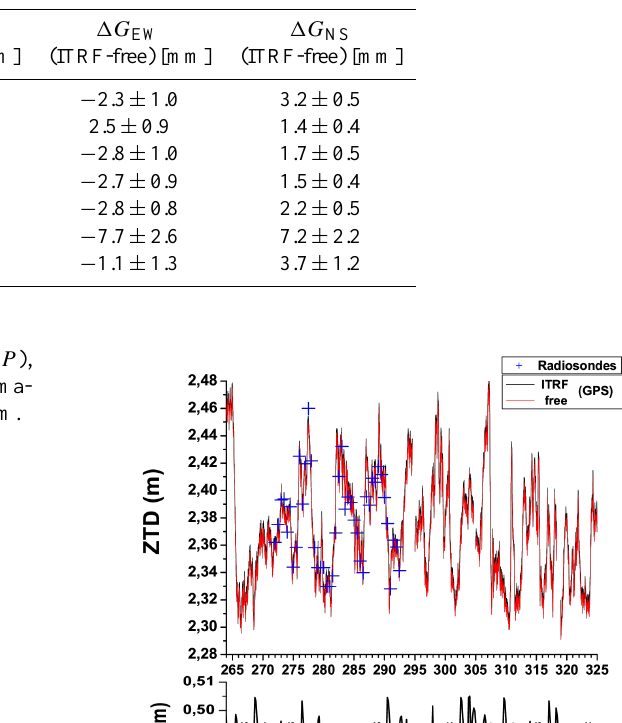
Table 4. Bias ( 1) and standard deviation ( δ) comparing 61 days of ZTD and vertical position estimates from unconstrained (free) and constrained solutions (ITRF), and ZTD from unconstrained and constrained solutions compared to equivalent ZTD from RS data (21 days). Units are mm.